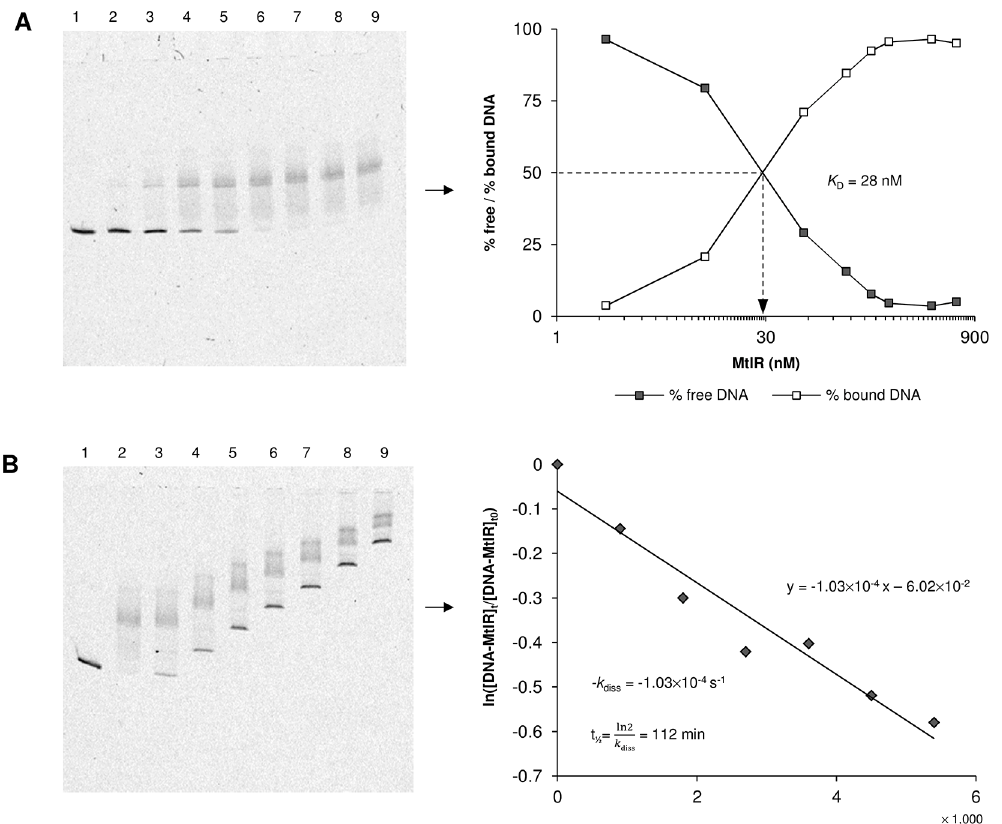
Fig 7. Determination of the equilibrium dissociation constant ( K D ), dissociation rate ( k diss ) and half life time (t ½ ) of the MtlR monomer binding to its upstream binding site. (A) Representative EMSA and determination of K D . Lanes: (1) 2 nM Cy5-labelled operator DNA, (2 – 9) 2 nM Cy5-labelled operator DNA + 2, 11, 56, 111, 167, 223, 445, or 667 nM MtlR. The average K D values of at least three independent experiments were 30.8 ± 4.8 nM with mannitol and 32.6 ± 5.0 nM without mannitol. (B) Representative EMSA and determination of k diss and t ½ . Lanes: (1) 2 nM Cy5-labelled operator DNA, (2) 2 nM Cy5-labelled operator DNA + 445 nM MtlR, (3 – 9) 2 nM Cy5-labelled operator DNA + 445 nM MtlR + 100 nM non-labelled competitor DNA loaded onto the gel 0, 15, 30, 45, 60, 75, and 90 min after addition of the competitor. The average k diss and t ½ values of at least three independent experiments were 1.1×10 − 4 ± 2.8×10 − 5 s -1 and 112 ± 24 min with mannitol and 1.2×10 − 4 ± 2.8×10 − 5 s -1 and of 99 ± 23 min without mannitol. The second upper band in some of the lanes on gel B is considered as an electrophoresis artefact (compare Fig 5C).